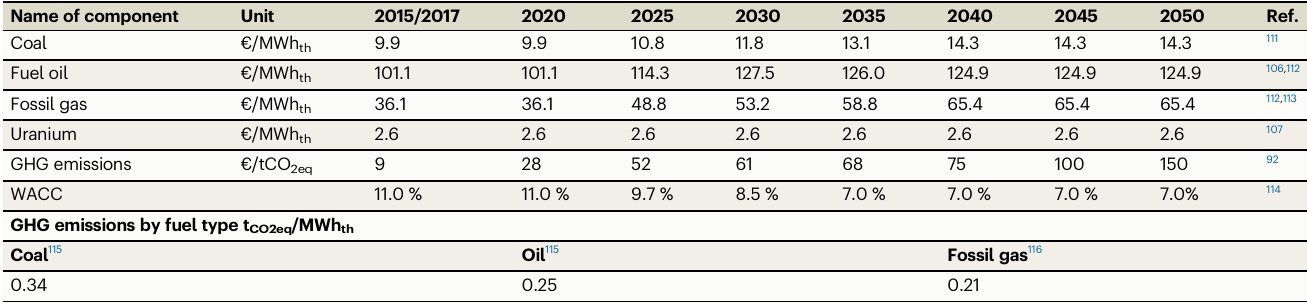
Table 3 | Financial assumptions for the fossil and nuclear fuel prices and GHG emission cost Name of